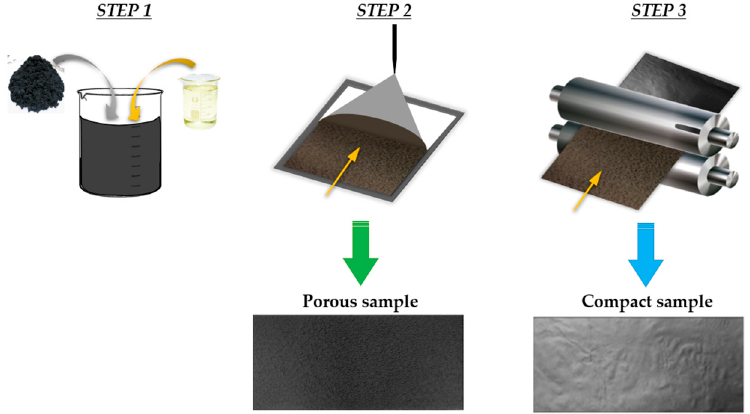
Figure 1. Manufacturing process: Step (1), dispersion and mixing of GNP particles in acetone with epoxy; Step (2), spray deposition of GNP/polymer/acetone mixture; Step (3), calendaring. Table 1. List of tested materials: C = compact; P = porous.